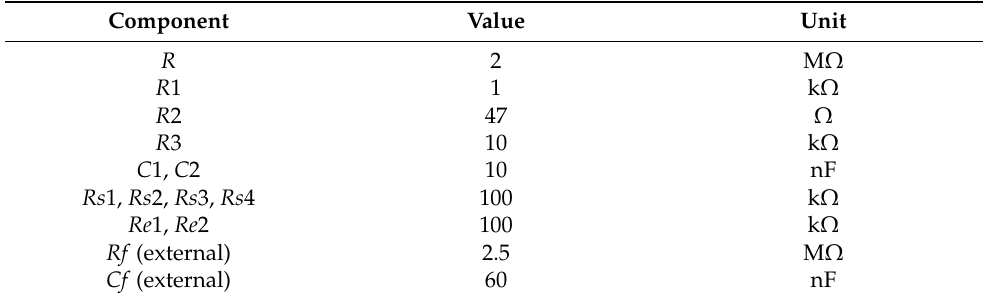
Table 2. Passive component values of the discrete